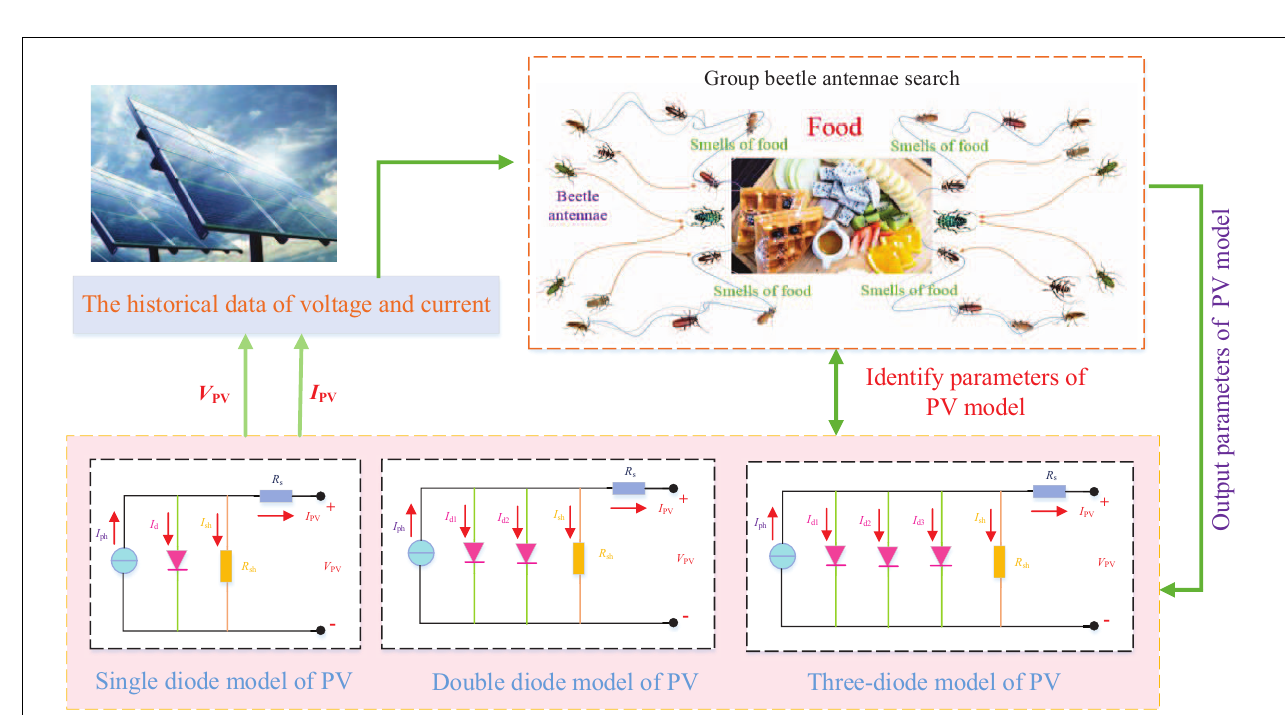
FIGURE 1 | Application process of grouped beetle antennae search (GBAS) for parameter identification of photovoltaic (PV) cell.